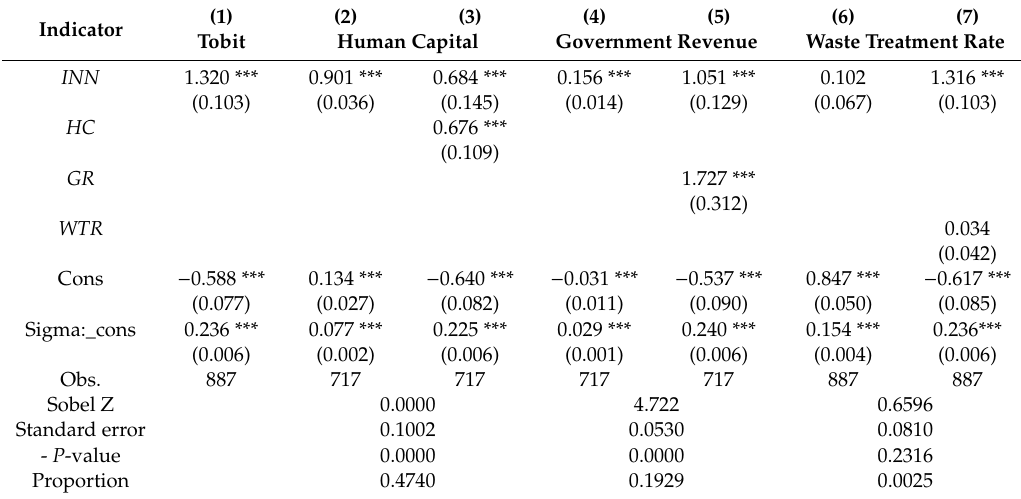
Table 3. Regression results for the mediation e ff